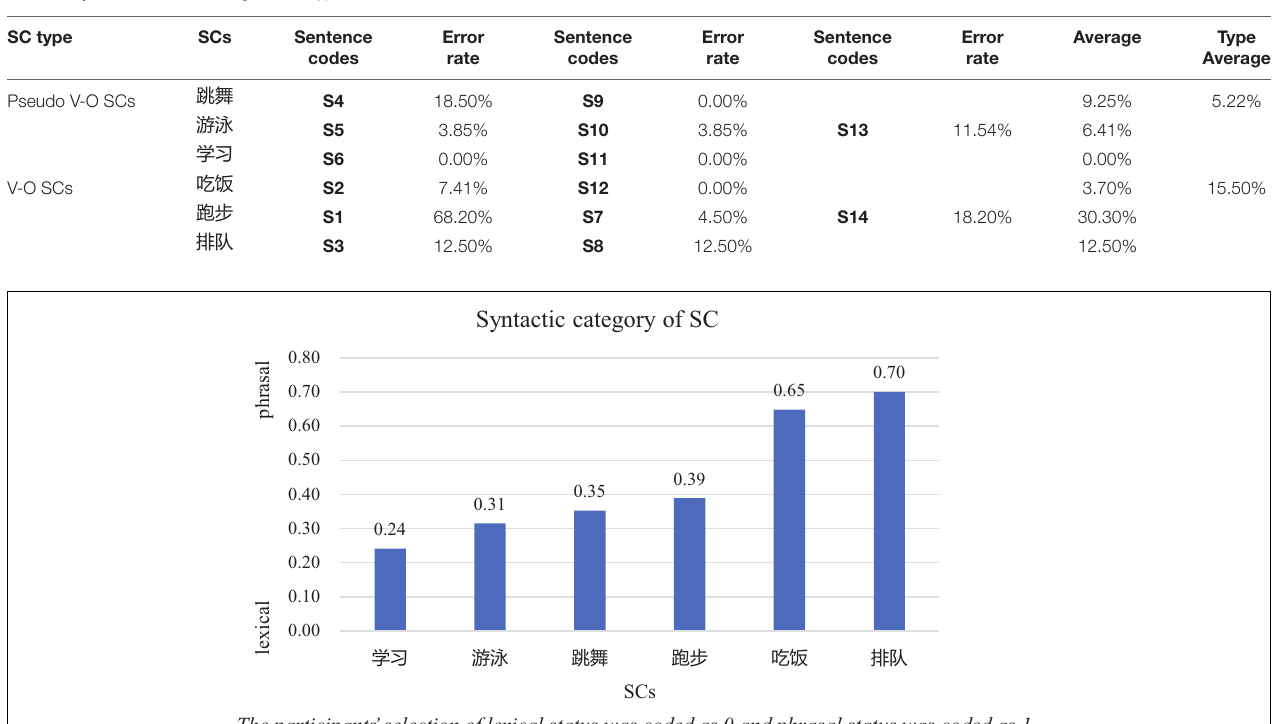
R stands for the count of recognized cases. TABLE 6 | Error rate concerning the SC types.